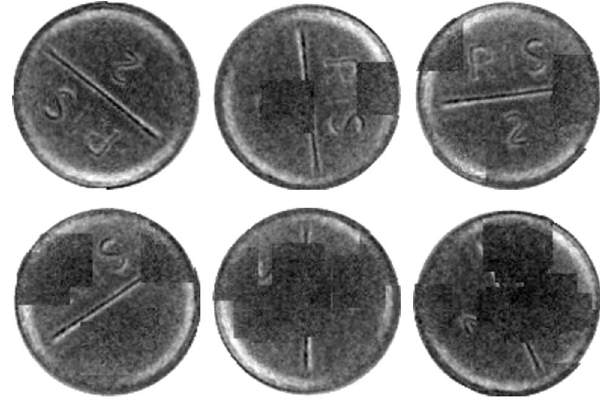
Figure 12. Synthetically degraded dataset. Occlusion patches are randomly spread over the tablet surface. Figures show samples with 0 { 50 % of the area occluded.